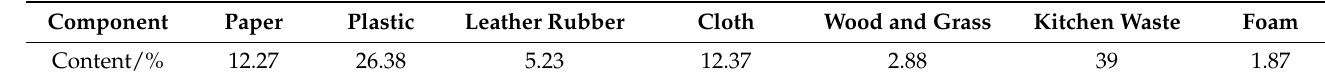
Table 3. The components of